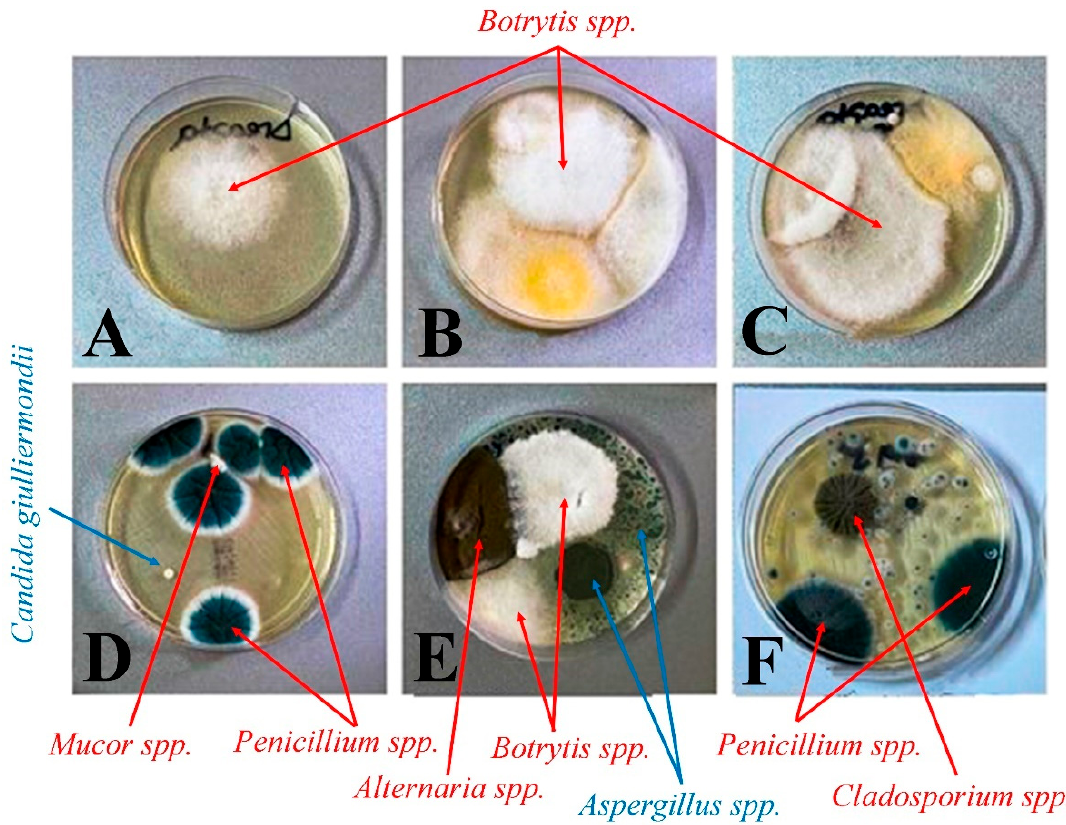
Figure 3. Plates seeded with primary samples (before application of essential oils). Reading taken after 7 days of incubation ( A )— Lavandula angustifolia ; ( B )— Cistrus lemon ; ( C )— Mentha piperita ; ( D )— Melaleuca alternifolia ; ( E )— Marjoram ; ( F )— Origanum vulgare .